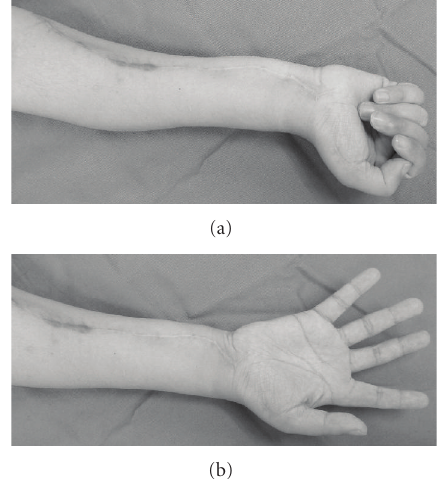
Figure 4: Photograph of right forearm on 2 years after operation. Grasp power of the a ff ected hand has gained up to 50%, and the sensory of the median nerve area has also been recovered up to 50% of the una ff ected